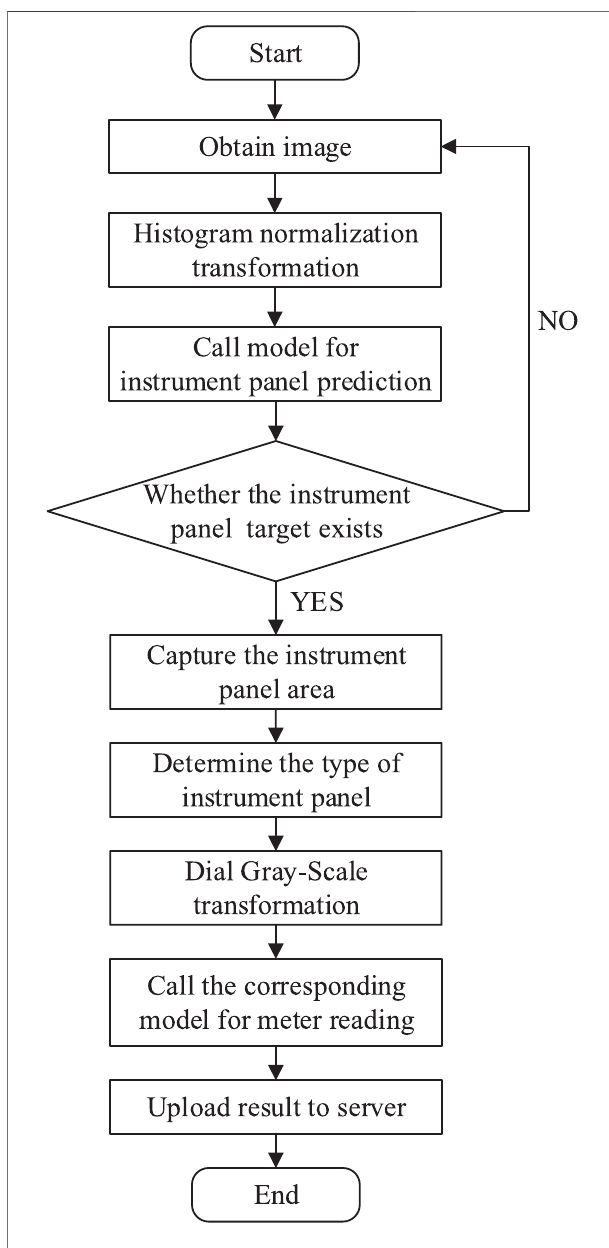
FIGURE 2 | RK3399 microcomputer work fl ow fl